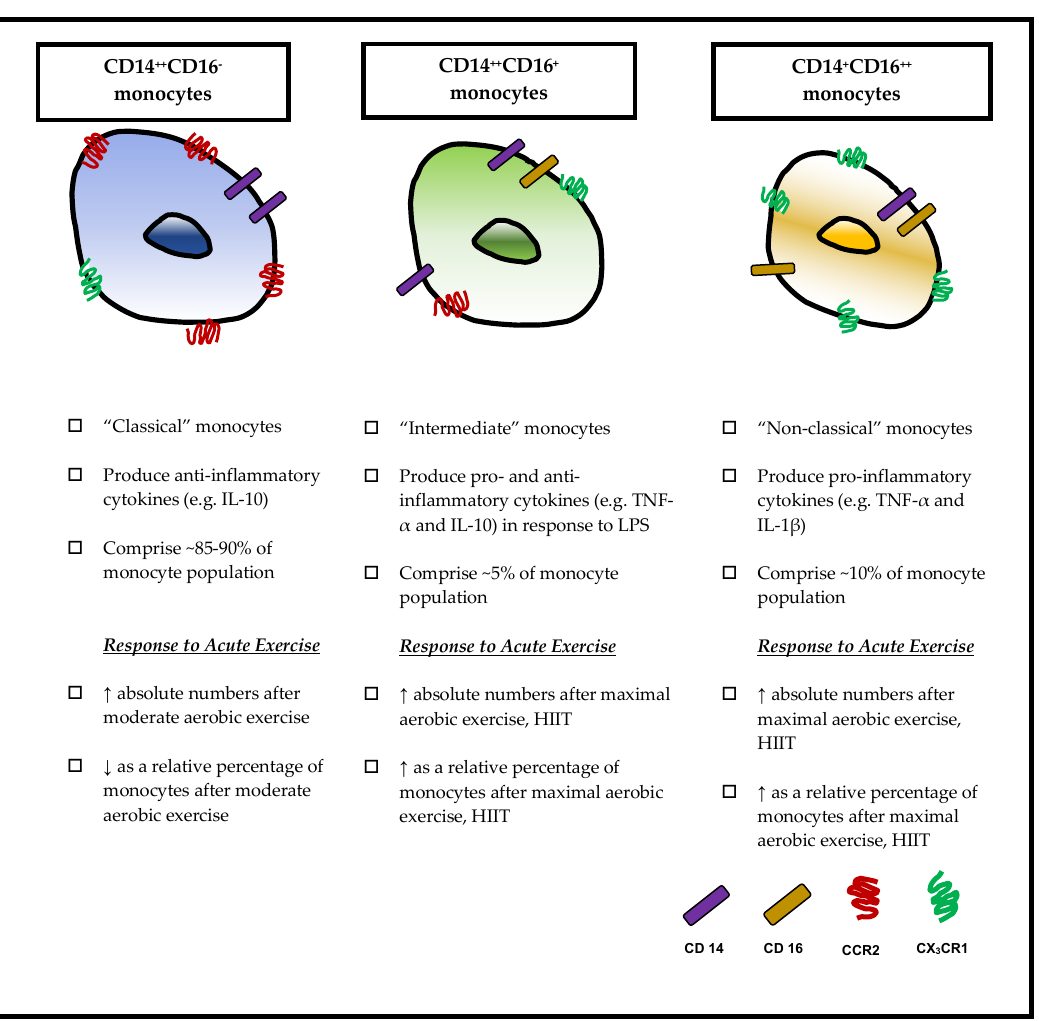
Figure 1. Monocyte subsets and responses to acute